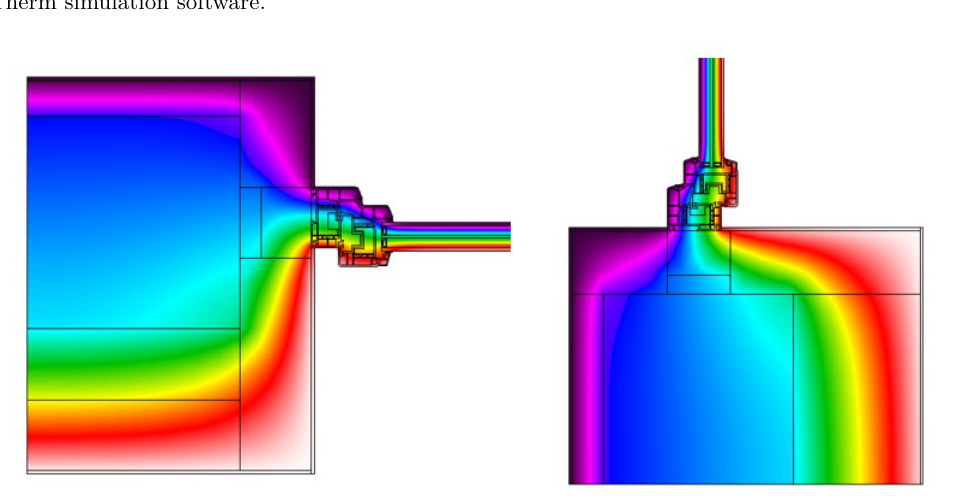
Table 5. Comparison of surface temperatures measured in the pavilion and climate chamber with temperatures from the Therm simulation software.